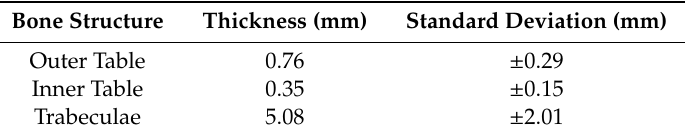
Table 2. Micro CT measurements